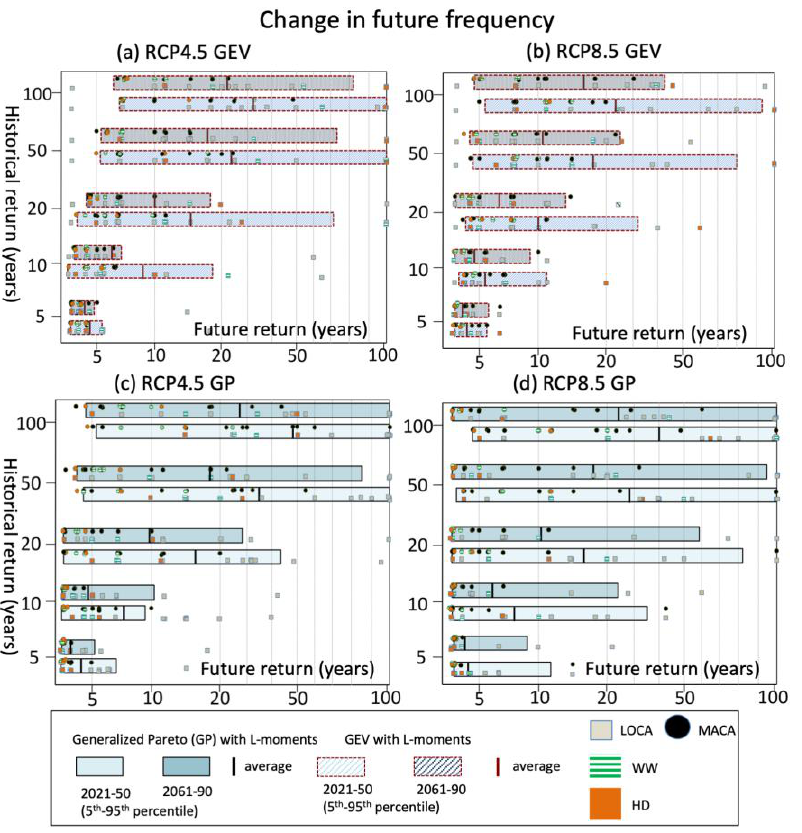
Figure 7. Changes in the frequency of precipitation extremes at various return intervals. Panels ( a , b ) show results using GEV with annual maxima; panels ( c , d ) use GP with POT (top 5%). Shaded bars depict the 5th–95th percentile range in the projections, and the average by the vertical bar within each box. Values for individual projections include MACA (dots) and LOCA (squares), with HD and WW subsets shaded differently from the full ensemble. Return intervals were calculated over a range between 2 and 100 years. Values outside of this range were not estimated; therefore, any intervals that would have fallen outside of this range in the future period are not available.